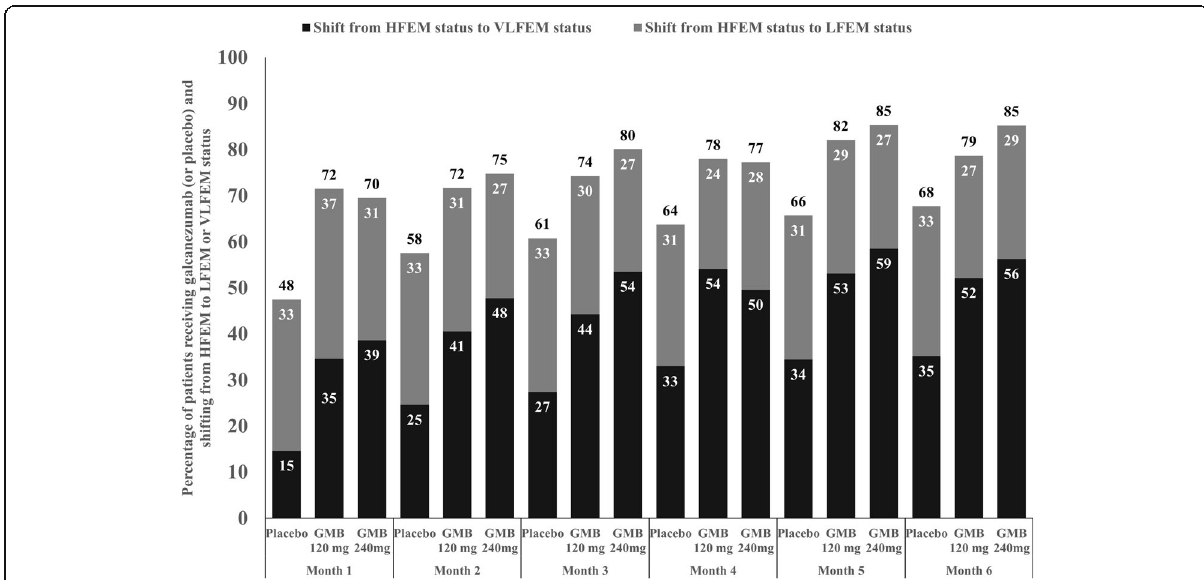
Fig. 1 Percentage of HFEM patients at baseline receiving galcanezumab (versus placebo) and shifting from HFEM status to LFEM status, or HFEM to VLFEM status at each month during the treatment period. Abbreviations: GMB, galcanezumab; HFEM, high-frequency episodic migraine; LFEM, low-frequency episodic migraine; n, number of patients who were categorized as HFEM at baseline with a baseline value and at least one post- baseline value recorded; VLFEM, very low-frequency episodic migraine. Note: The percentages shown in the figure are raw values at each month and treatment group. P values comparing galcanezumab vs placebo are from the following GLIMMIX model for repeated measures: Shift from